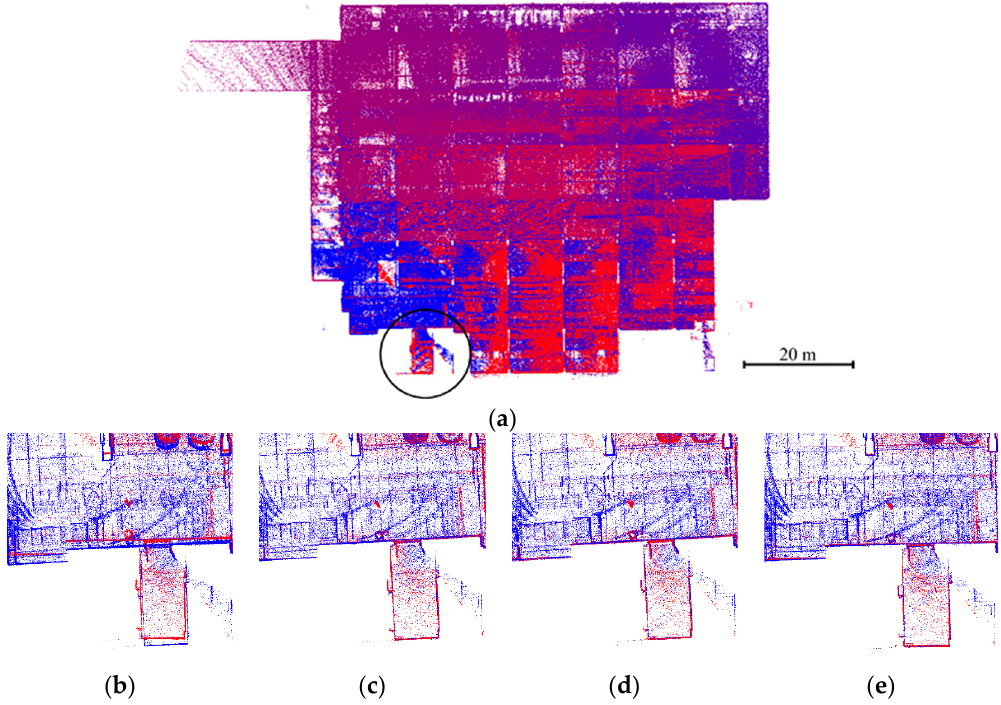
Figure 10. Comparison between the point clouds before and after optimization in dataset 2. ( a ) The top view of the point cloud after optimization; ( b ) enlarged view of the raw output point cloud of Cartographer; ( c ) enlarged view of the optimized point cloud of Cartographer; ( d ) enlarged view of the raw output point cloud of LOAM; ( e ) enlarged view of the optimized point cloud of LOAM.